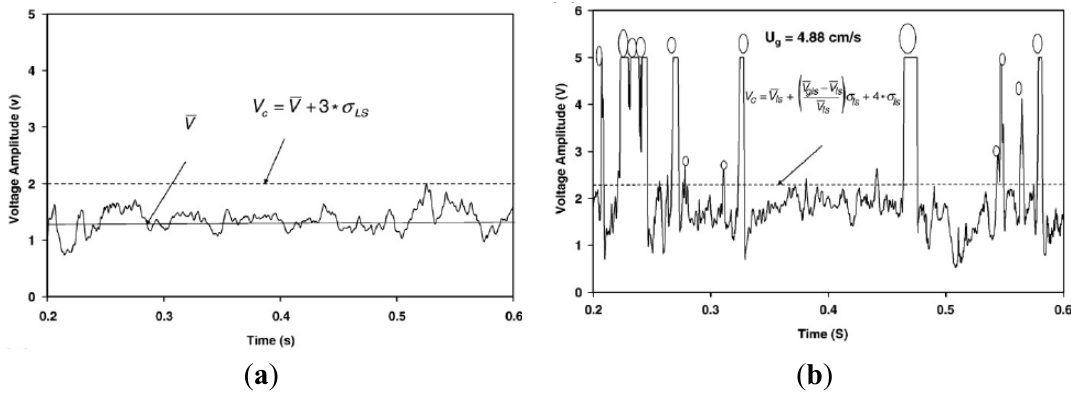
Figure 11. The typical voltage output signal produced by an optical fiber probe for ( a ) liquid-solid; and ( b ) gas-liquid-solid system in a GLSCFB riser for glass beads [127]. In a liquid-solid system, the critical voltage range ( V ), the signal V above which indicates a c detected particle, is the average voltage ( V ) plus 3 times the standard deviation of the liquid-solid system ( σ ). In a gas-liquid-solid system, the criterion for gas bubble LS detection is similarly determined as 4 GLS , in which the average and standard deviation of LS and GLS systems are